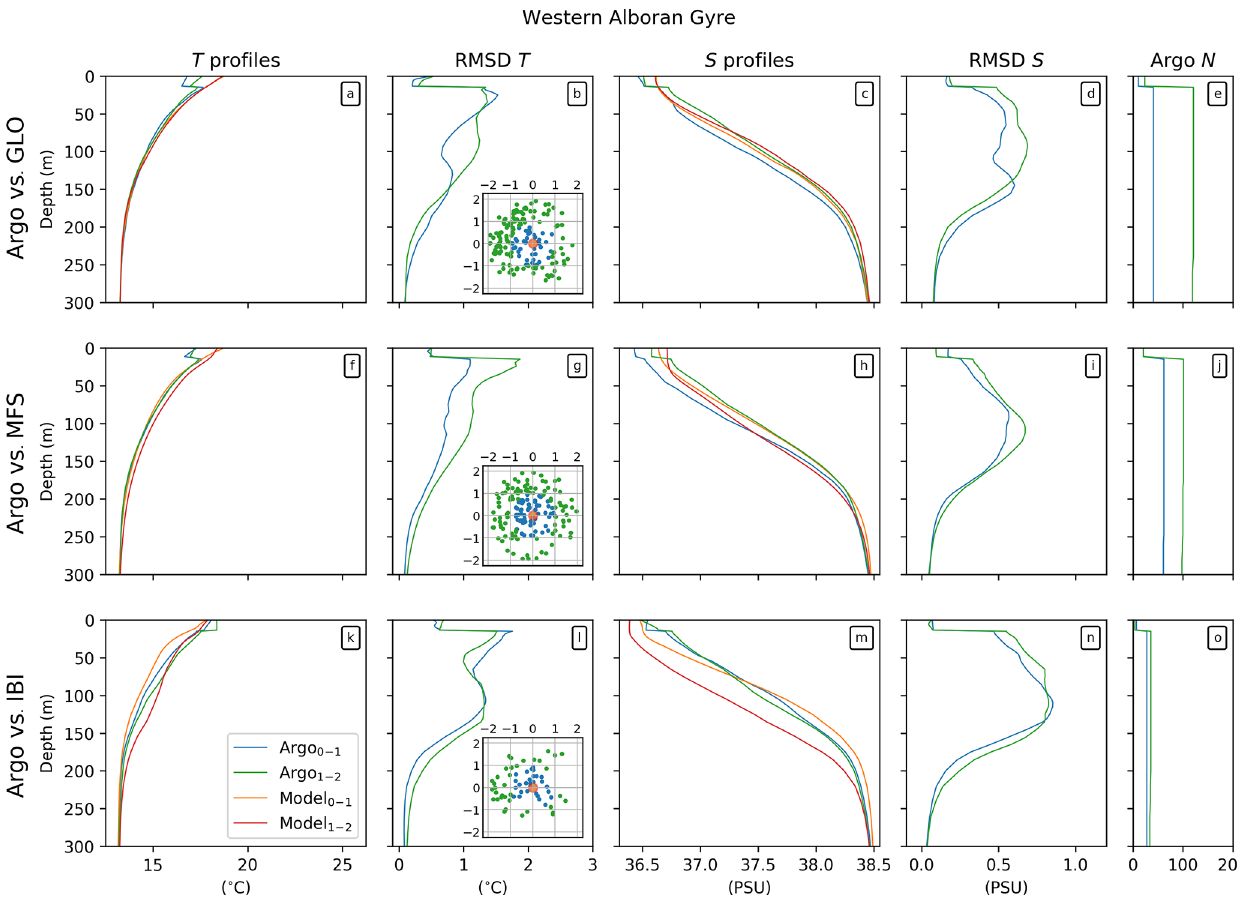
Figure 11. Comparison of temperature and salinity–depth profiles at the center of each model anticyclonic eddy and its nearest Argo observa- tion in the Western Alboran Gyre subregion. The first column shows mean T profiles for the respective models and Argo; the second column shows the corresponding T root mean square deviations with depth between the model and Argo T observations. Argo profiles colored blue (green) are located inside (outside) the eddy radius, viz. 0–1 L , 1 L –2 L , as indicated in the inset eddy-centric-coordinate maps in the second column that show the relative (to the eddy center) positions of each Argo profile. The respective model profiles corresponding to the Argo selections are colored orange and red. Profiles in the third and fourth columns show the results for S . The Argo sample size ( N ) at each depth for each model is found in the fifth column. Rows show GLO (top), MFS (middle) and IBI